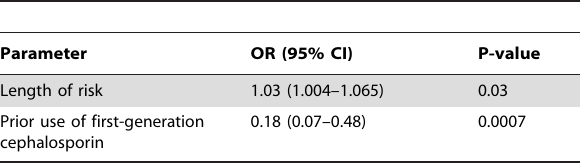
Table 3. Multivariate analysis of risk factors for acquiring VRE during ICU